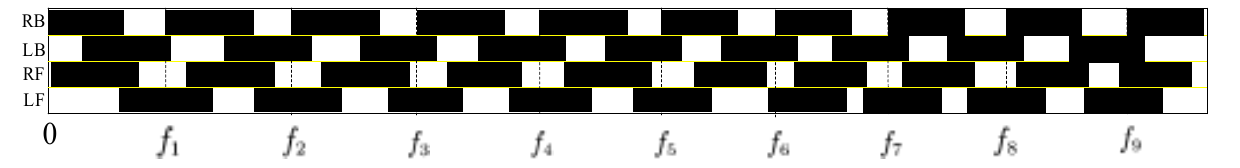
Figure 7. Gait phase diagram of each limb’s gait (left front leg, right front leg, left hind leg, and right hind leg).